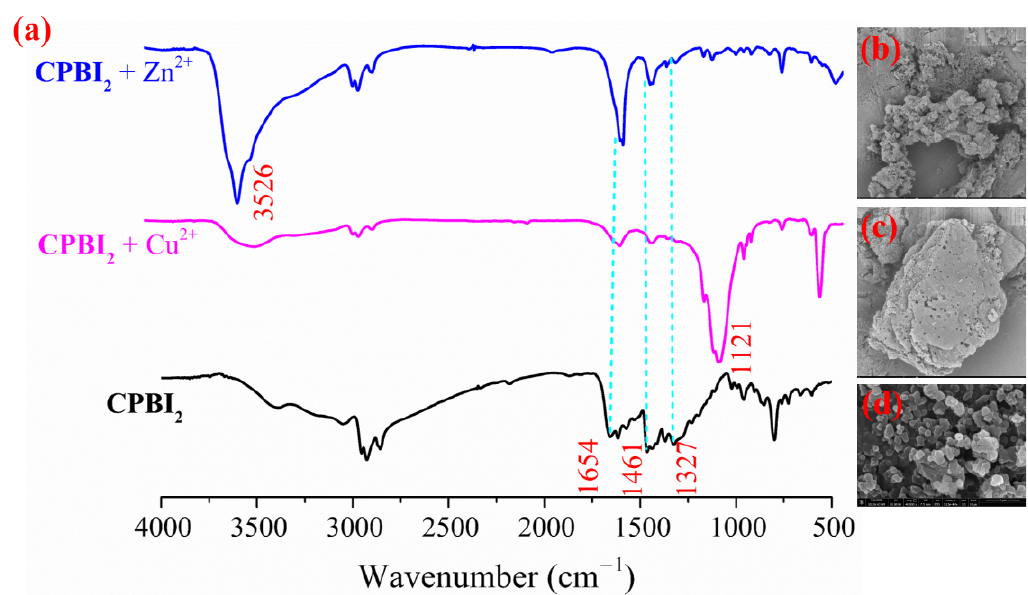
Figure 7. FT-IR spectra ( a ), SEM images of CPBI 2 before and after the addition of Cu 2+ or Zn 2+ (( b ): CPBI 2 +Zn 2+ ; ( c ): CPBI 2 +Cu 2+ ; ( d ): CPBI 2 ).